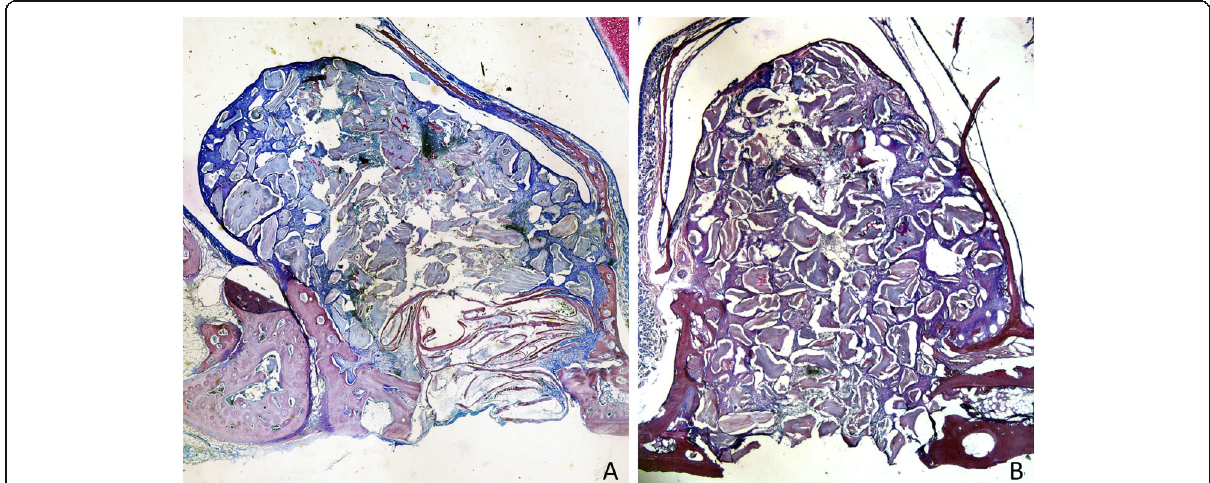
Fig. 3 Photomicrographs of decalcified sections illustrating the healing after 1 week. a Treated site. Bone strips occupying the antrostomy and the subjacent area (close-to-window region). b Untreated site. Note the new bone-forming from the sinus bone walls. Scarlet-acid fuchsine and toluidine blue stain. Images grabbed at × 20 magnification